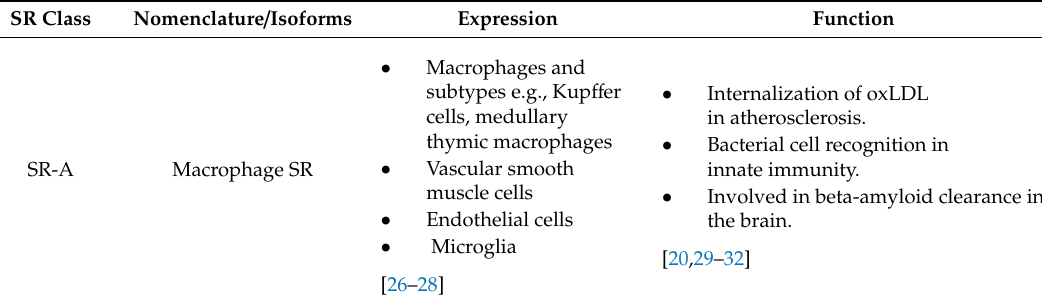
Table 1. SR expression and